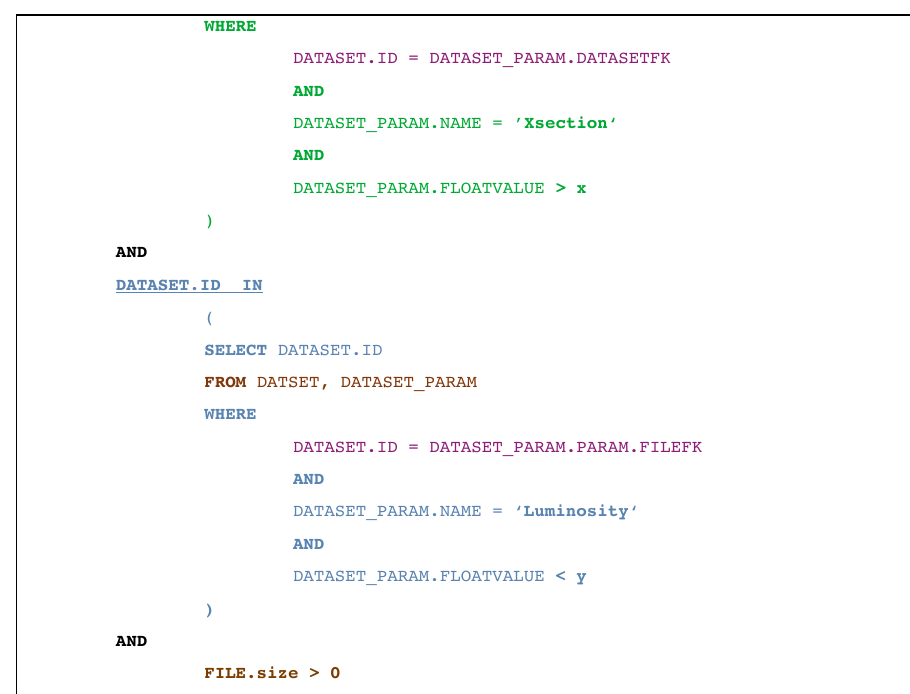
Figure 6. SQL query generated form the MQL query of Figure